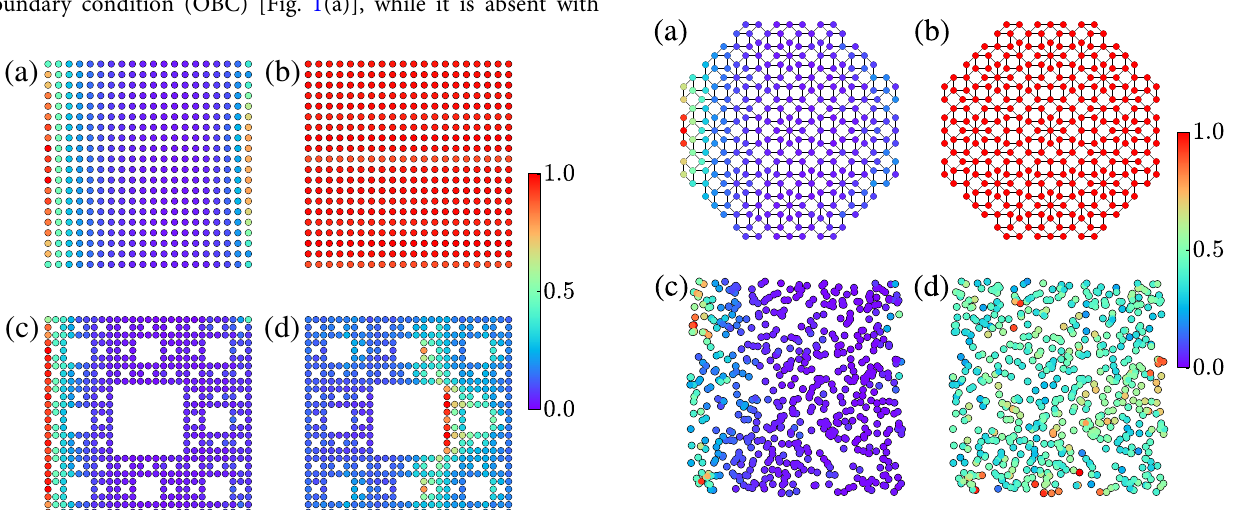
Fig. 2 Skin effect on Ammann-Beenker quasicrystal and amorphous network. a Non-Hermitian skin effect for the left eigenvectors of H FO on the left edge of an octagonal Ammann-Beenker quasicrystal with open boundary condition (OBC) for t = t 0 = 1, m = 1.0, h x = 0.75, R = 2 a and r 0 = a , where a is the length of its each arm (black line). b Same as a , but with periodic boundary condition (PBC) in the x direction, showing no skin effect. c Same as a , but on an amorphous network of 600 lattice sites for h x = 0.4 and R = 0.98 a . Here a is the linear dimension of the network in each direction. Other parameters are kept unchanged. d Same as c , but with PBC along the x direction. A few isolated and randomly distributed points on the network show a slightly higher densities. But, after averaging over many (typically 250) realizations, we fi nd that there is no skin effect in the bulk of an amorphous network with PBC. Right eigenvectors show skin effects on the right edges of both systems with OBC. See Supplementary Figs. 1 –